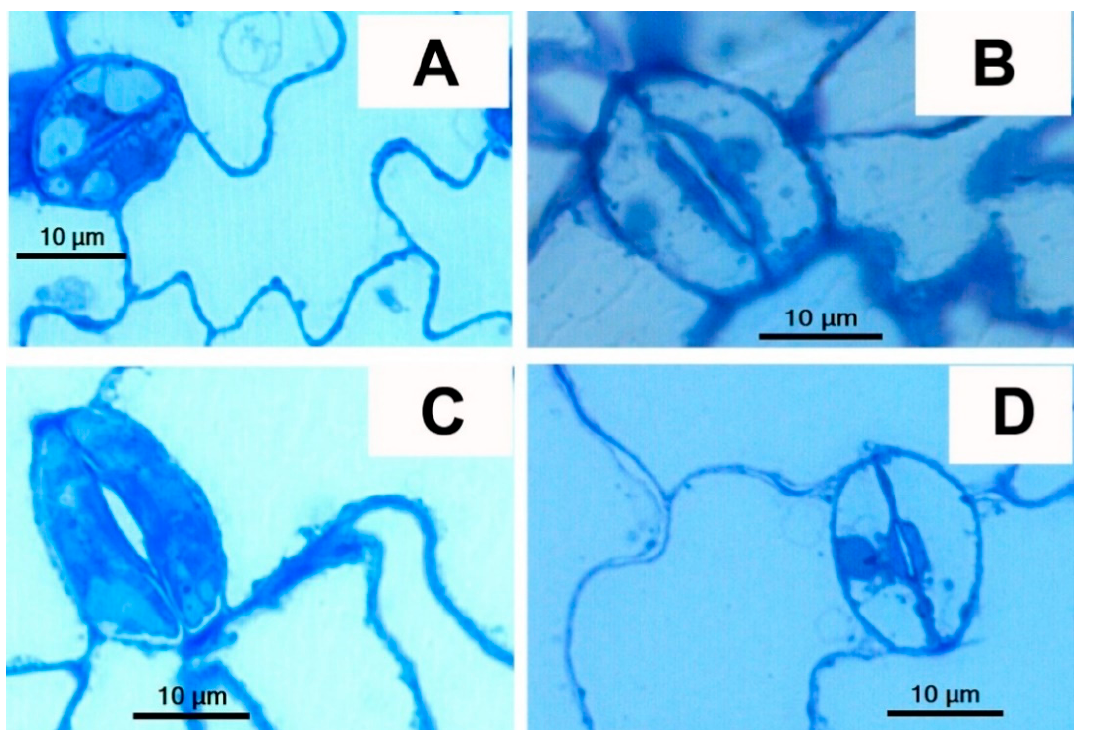
Figure 3. LM images of stomata and GCs from leaf segments of semi-thin sections (longitudinal) of rosette leaves of WT, tgg single and double mutants of Arabidopsis stained with toluidine blue. ( A ). WT: GC where vacuoles showed toluidine staining, ( B ). tgg1 single mutant: GC where vacuoles lacked toluidine blue staining, ( C ). tgg2 single mutant: GC where vacuoles showed toluidine staining, ( D ). tgg1 tgg2 double mutant: GCs vacuoles showed no toluidine staining. (Scale bars = 10 µm).